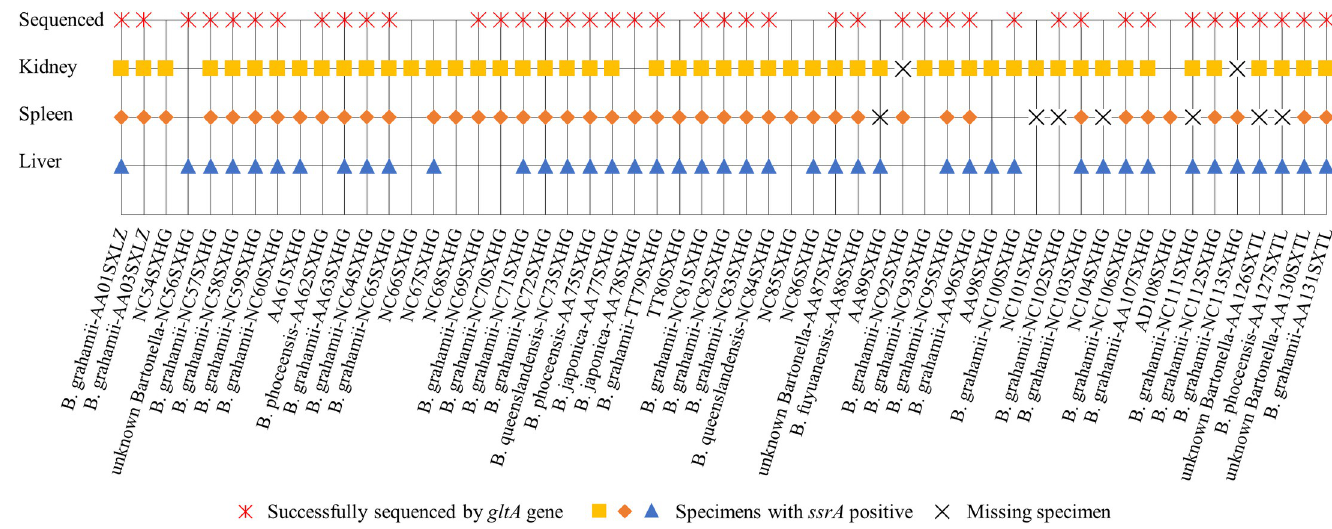
Fig 2. Phylogenetic tree constructed based on partial gltA gene (326 bp) of 42 Bartonella sequences. The tree was constructed by using the maximum-likelihood (ML) method with the Kimura 2-parameter model, bootstrap values calculated with 1000 replicates. The sequences detected in this study are indicated with black dots (NC represents Niviventer confucianus , AA represents Apodemus agrarius and TT represents Tscherskia triton ). Brucella abortus was used as outgroup.